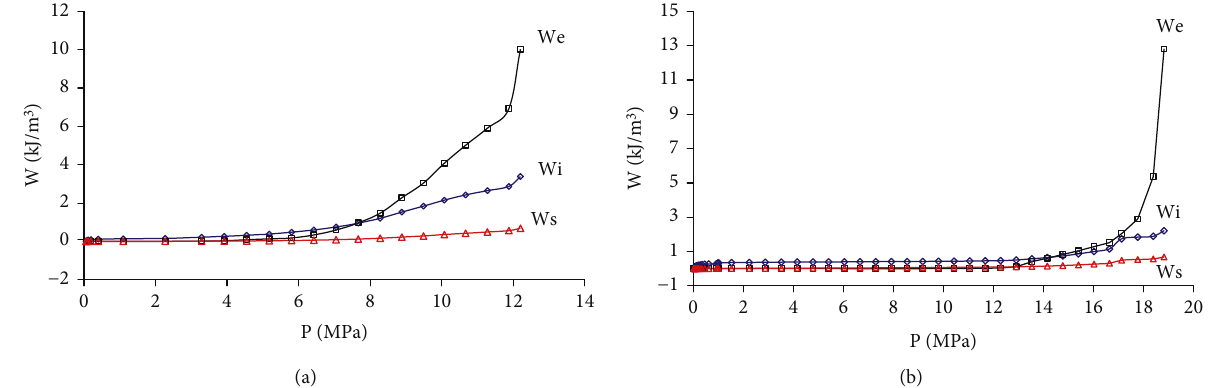
Figure 6: Comparison of the energy curves of hydrofracture. (a) Energy comparison curve of uniaxial compression hydrofracture. (b) Energy comparison curve of triaxial compression